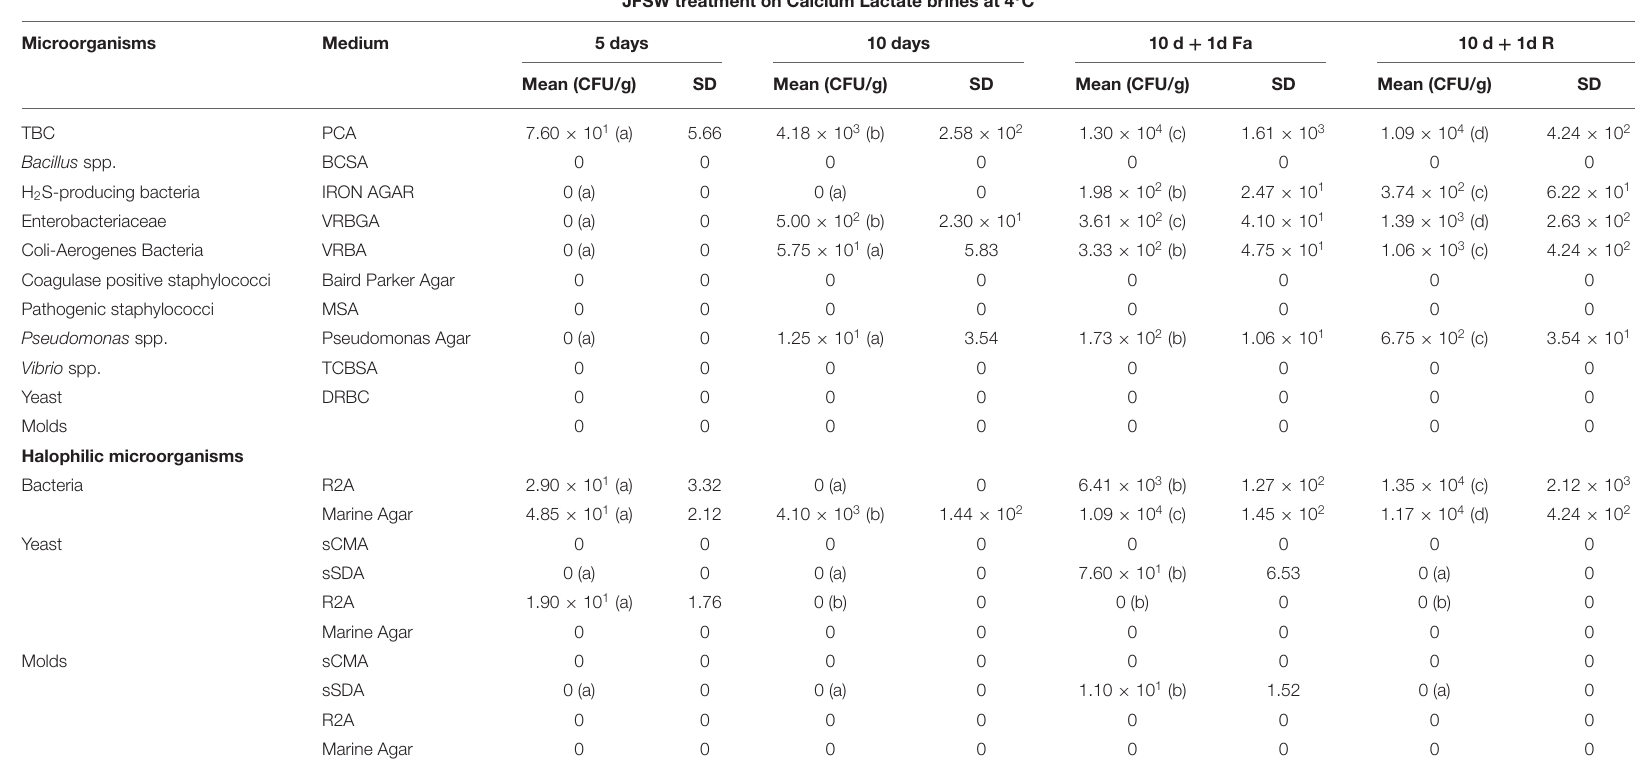
TABLE 2C | Microbiological analyses during time course treatment of JFSW in calcium lactate brines at 1, 5, and 10 days. JFSW treatment on Calcium Lactate brines at 4 ◦